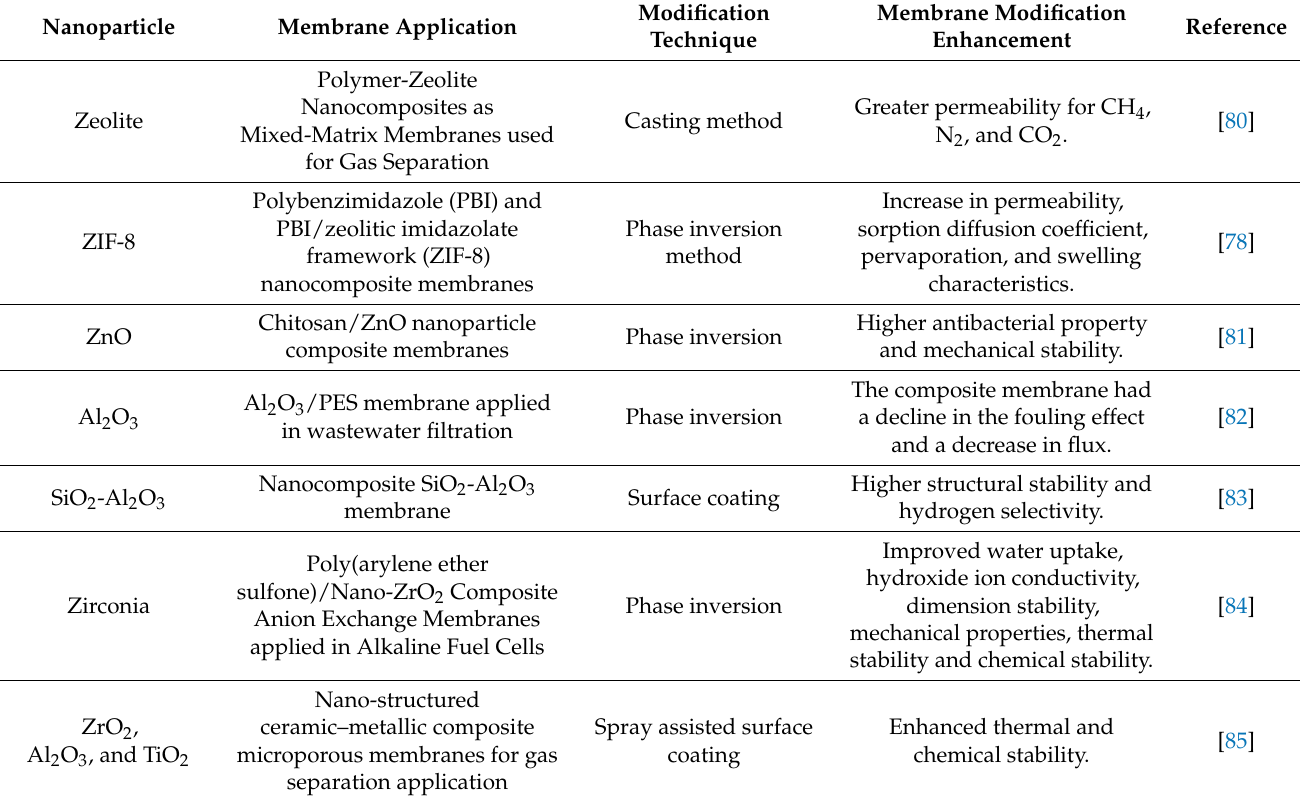
Table 4. A summary of key elements of several nanoparticle-based nanocomposite